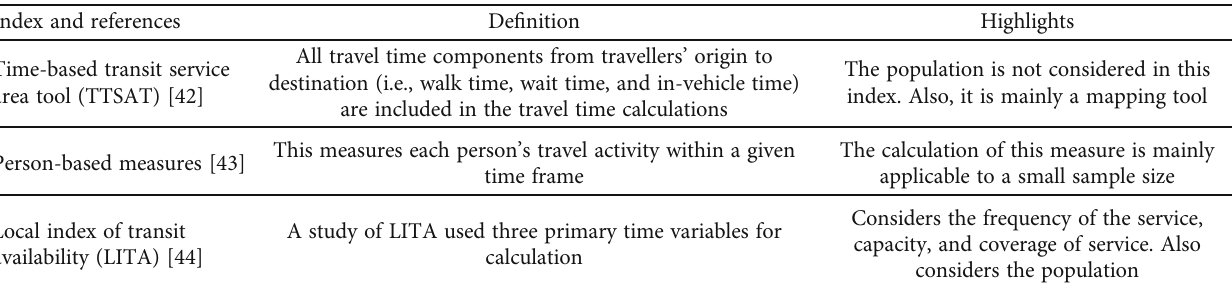
Table 2: Time-based PT accessibility index